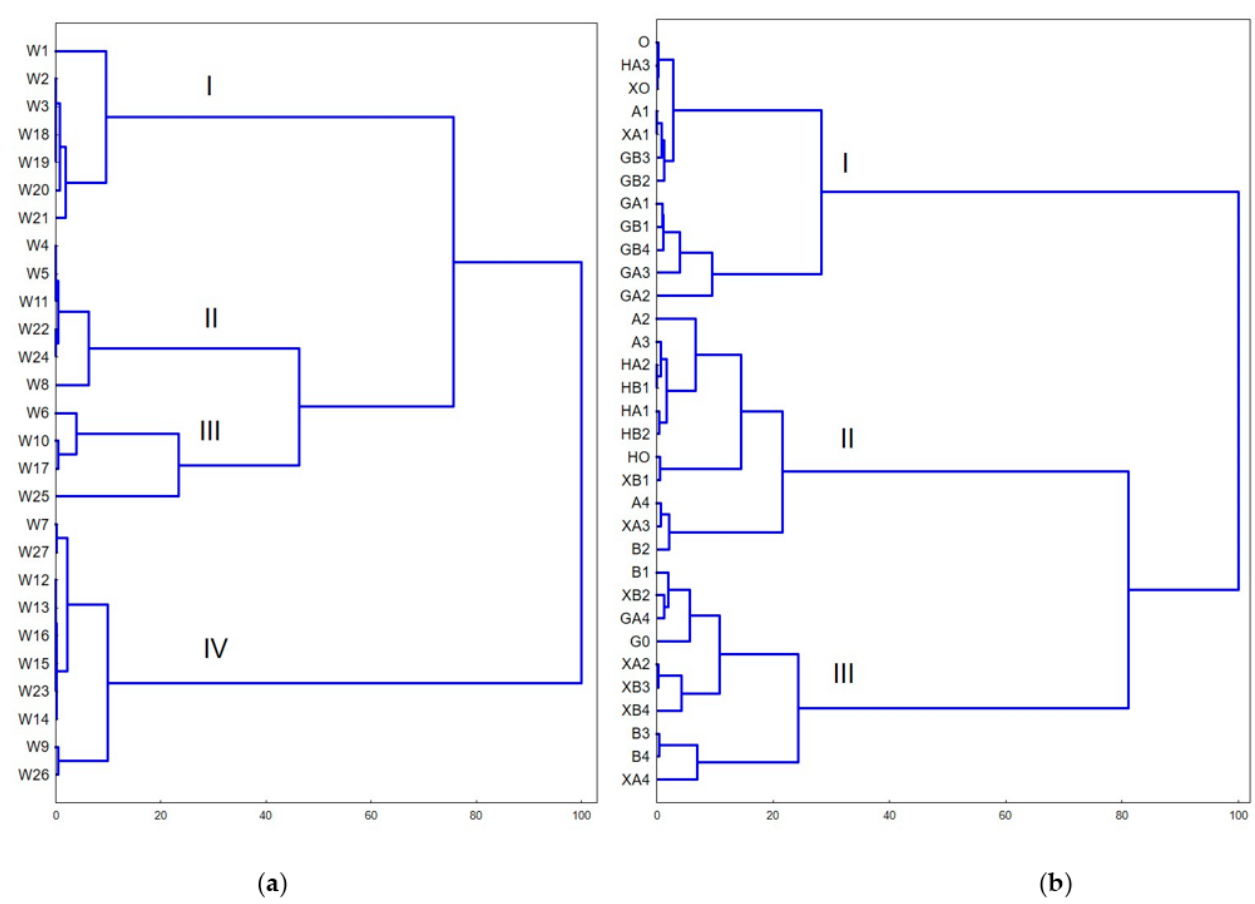
Figure 5. Dendrogram showing cluster analysis results for location sediment samples changes for the mouth of the Vistula ( a ) and the sewage collectors’ outlets from WTPs ( b ) (the Ward’s method, 1-rPearson distance) (I–IV-clusters).